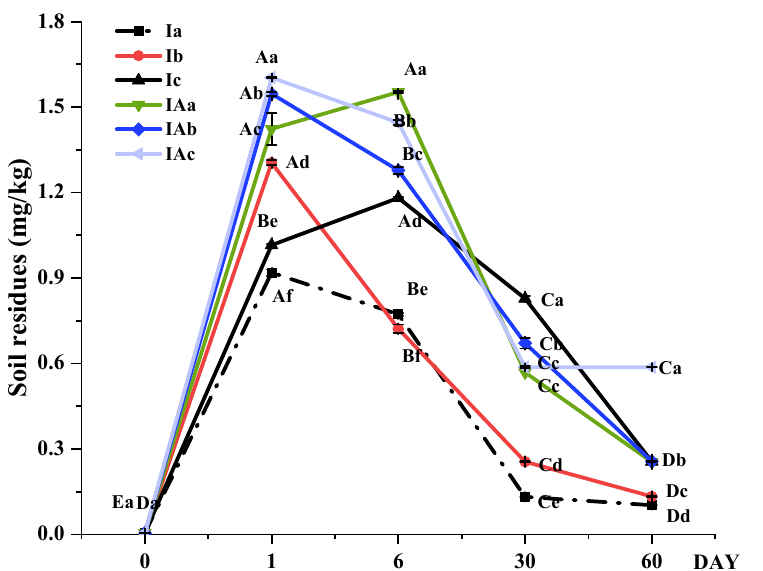
Figure 4. Pesticide residues in soil. The different lowercase letters indicate significant differences between the treatment groups ( p < 0.05), and the different uppercase letters indicate significant differences between time stages ( p < 0.05). Table 2. Correlation coefficients between residues and soil physicochemical properties and plant density. VWC